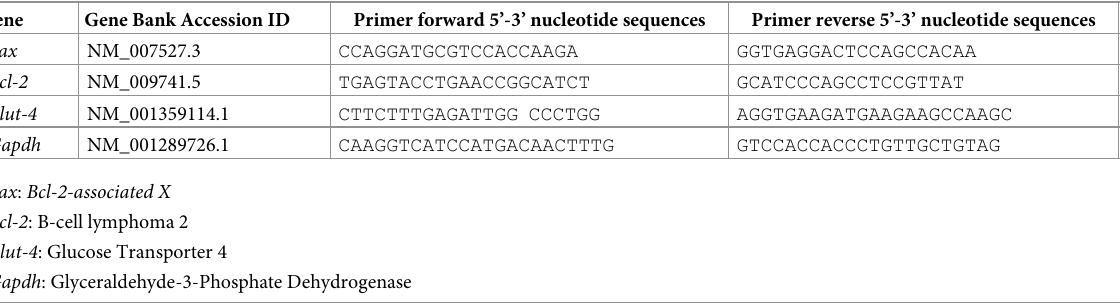
Table 1. Genes and sets of the primers used in qRT-PCR.